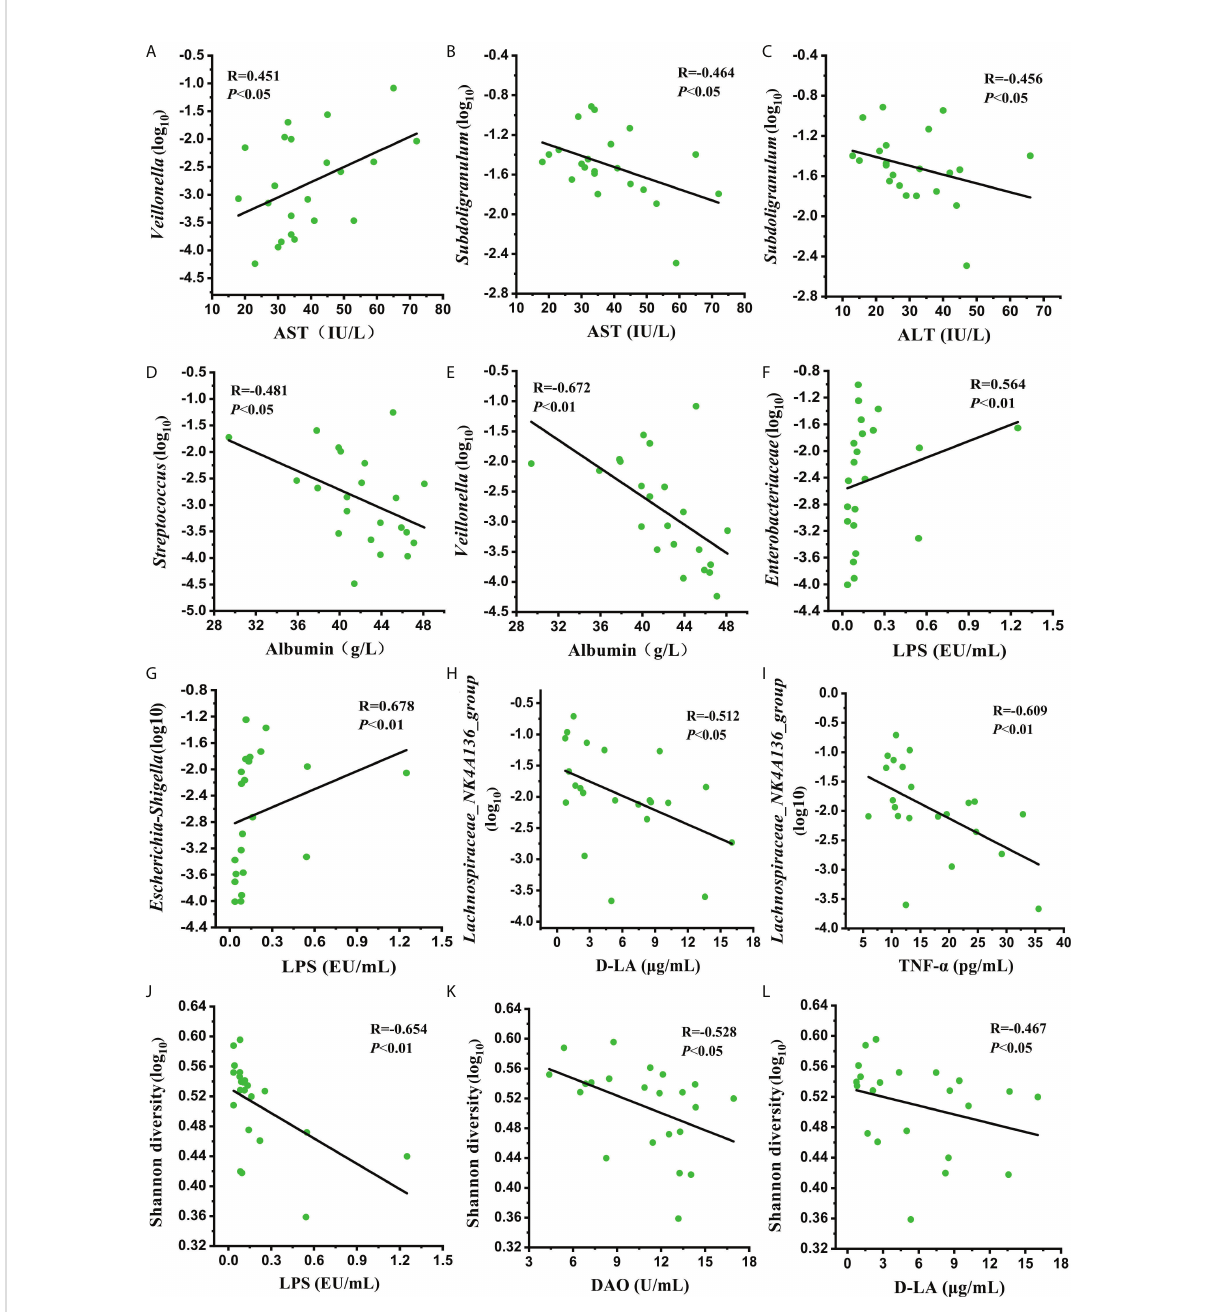
FIGURE 7 Correlation analysis of (A – E) the relative abundance of improved genera with liver damage and liver function indicators, (F – L) the relative abundance of improved bacterial taxa and Shannon diversity with intestinal permeability indicators at